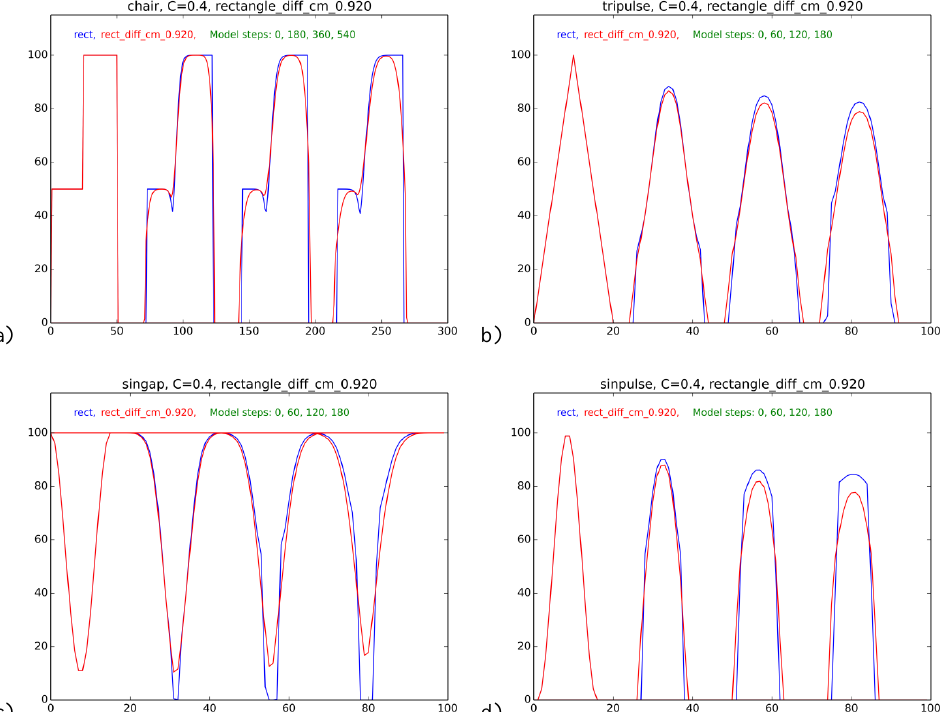
Figure 2. Shape preservation tests: (a) step, (b) triangle peak, (c) sine-shaped dip, and (d) sine-shaped peak. Sequential positions are shown: “r” denotes the scheme without a smoother, “r_diff” with it. The legend includes the number of times steps made. Wind is from left to right; Courant =